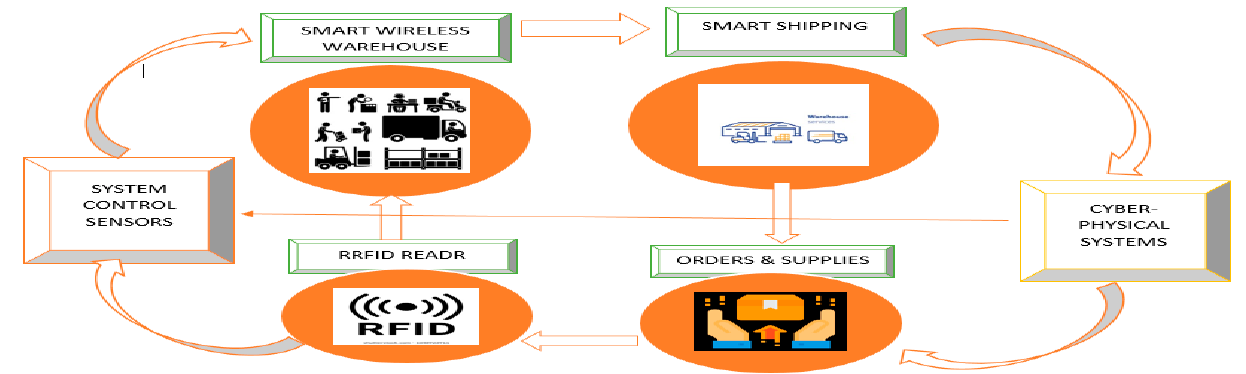
Figure 5. Internet of things (IoTs) for industrial use.